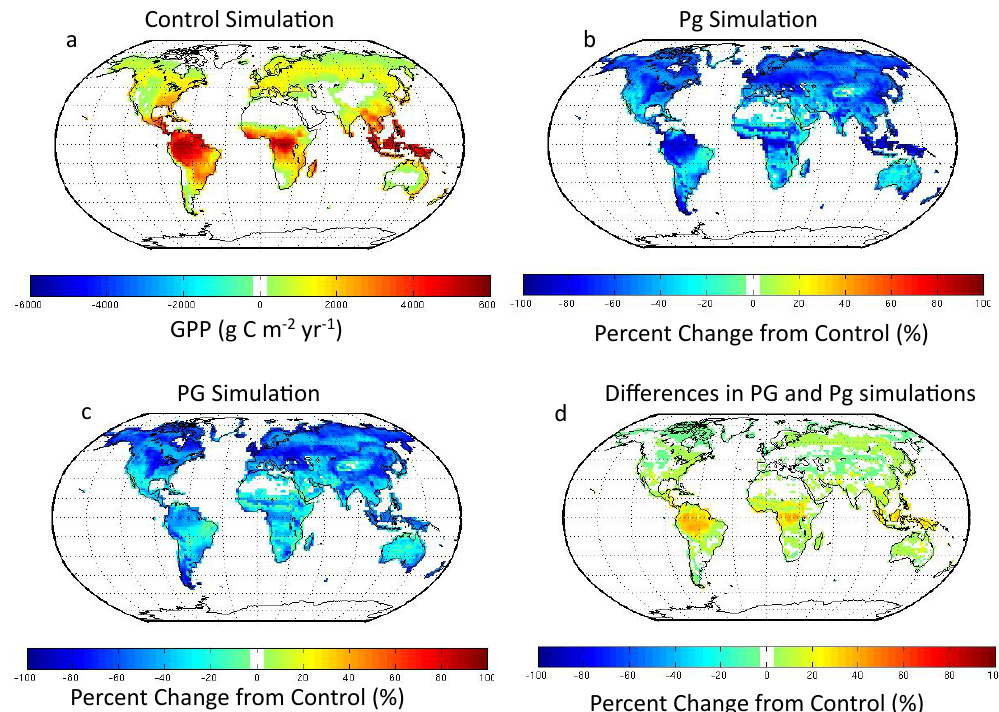
Fig. 5. Mean annual gross primary productivity (GPP) predicted in 20-yr CLM simulations run at 100ppb O 3 . The control simulation (a) shows the average amount of carbon gained via photosynthesis annually in the absence of O 3 . The percent changes from control were mapped for the (b) Pg simulation, where a direct change in photosynthesis causes changes in conductance and for the (c) PG simulation, where direct changes to photosynthesis and conductance occur independently. Panel (d) illustrates the differences in GPP between the PG compared to the Pg simulation, also mapped as a percent change from control.